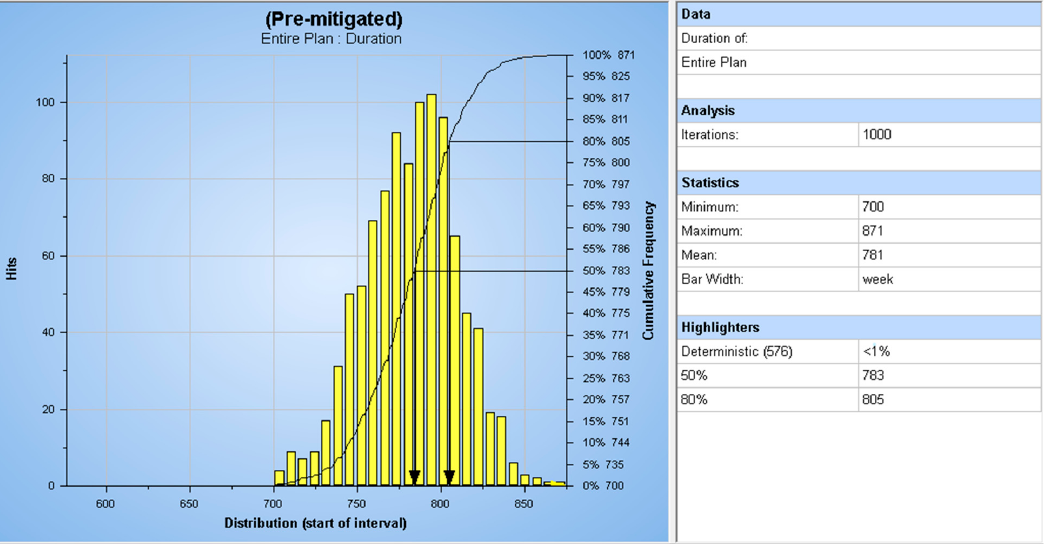
Figure 9. Histogram of the duration of the project before the implementation of measures to reduce or limit the impact of risks.